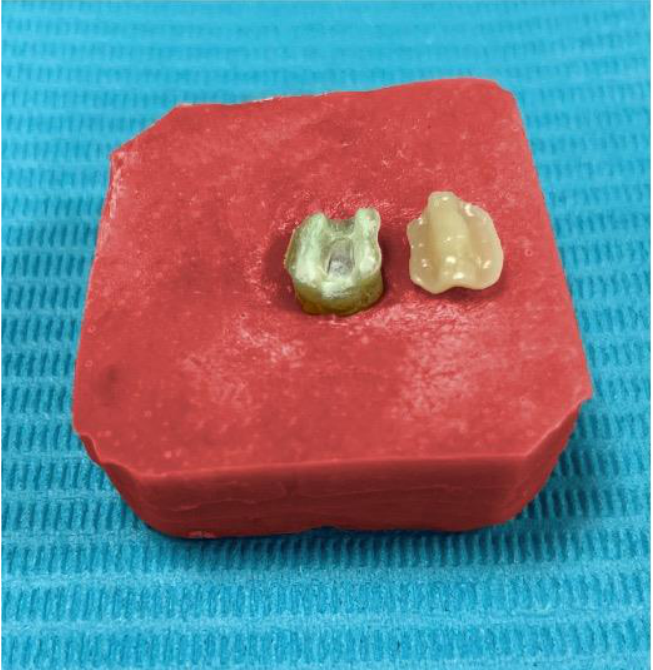
Figure 2. Abutment preparation for Endocrown design with mesial and distal extension boxes.